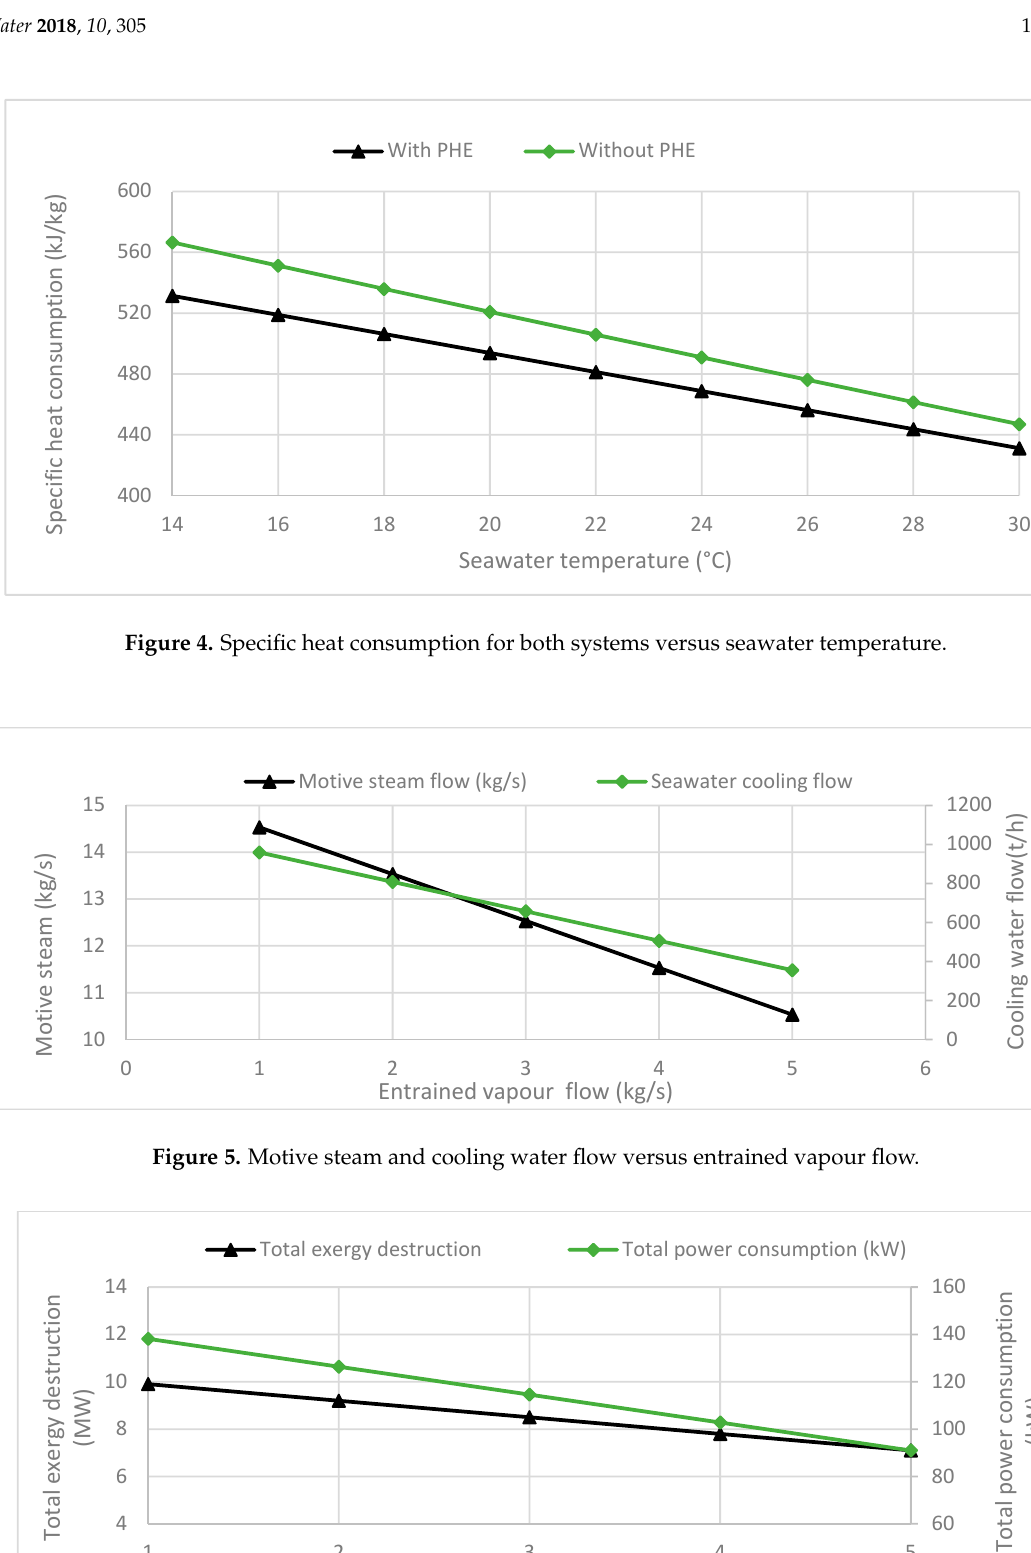
Figure 6. Total exergy destruction and total power consumption versus entrained vapour flow.